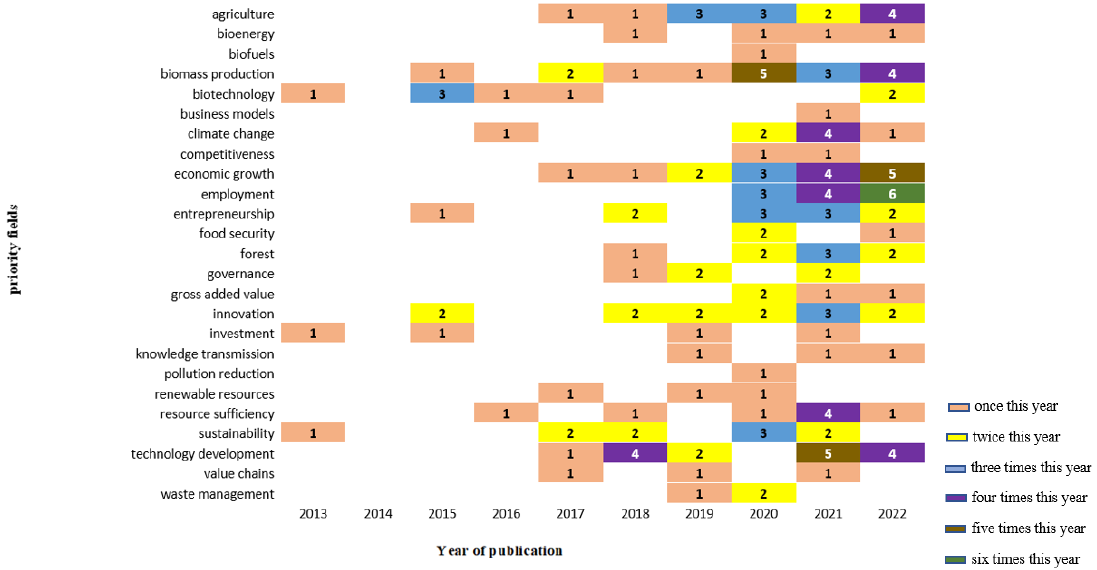
Figure 4. Number of documents including priority fields per year of publication. Source: authors’